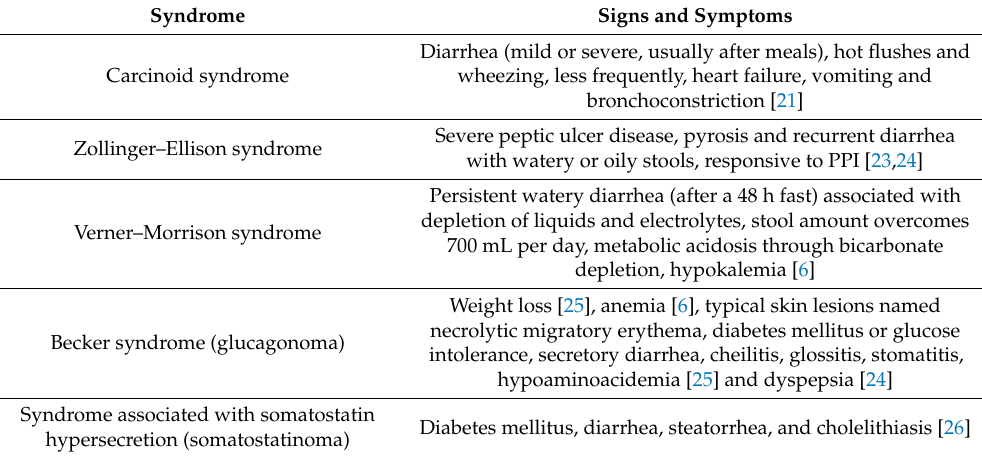
Table 1. Signs and symptoms of the di ff erent hormonal hypersecretory syndromes.